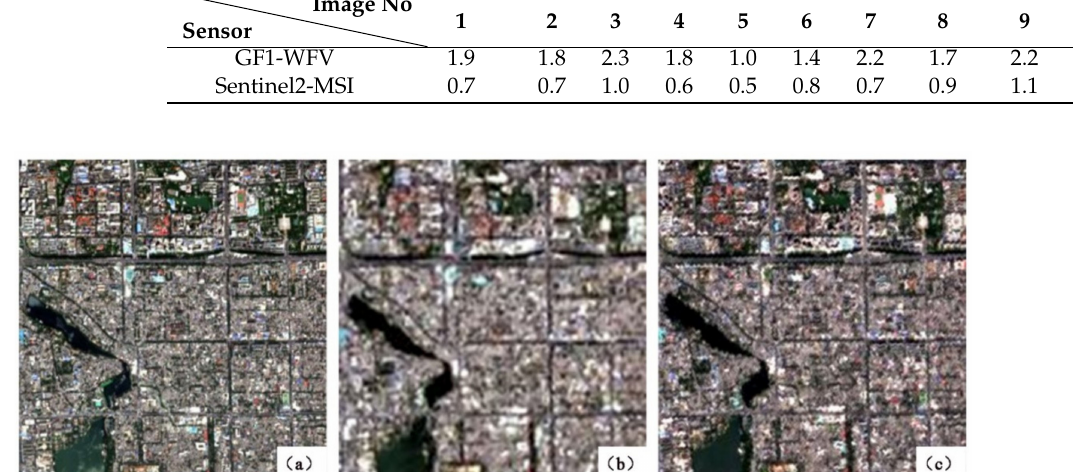
Figure 1. The true color composites are from Sentinel2A-MSI ( a ), Landsat8-OLI ( b ), and GF1-WFV ( c ), respectively before geometric normalization. The central location of these images is 116.39 ◦ E, 39.94 ◦